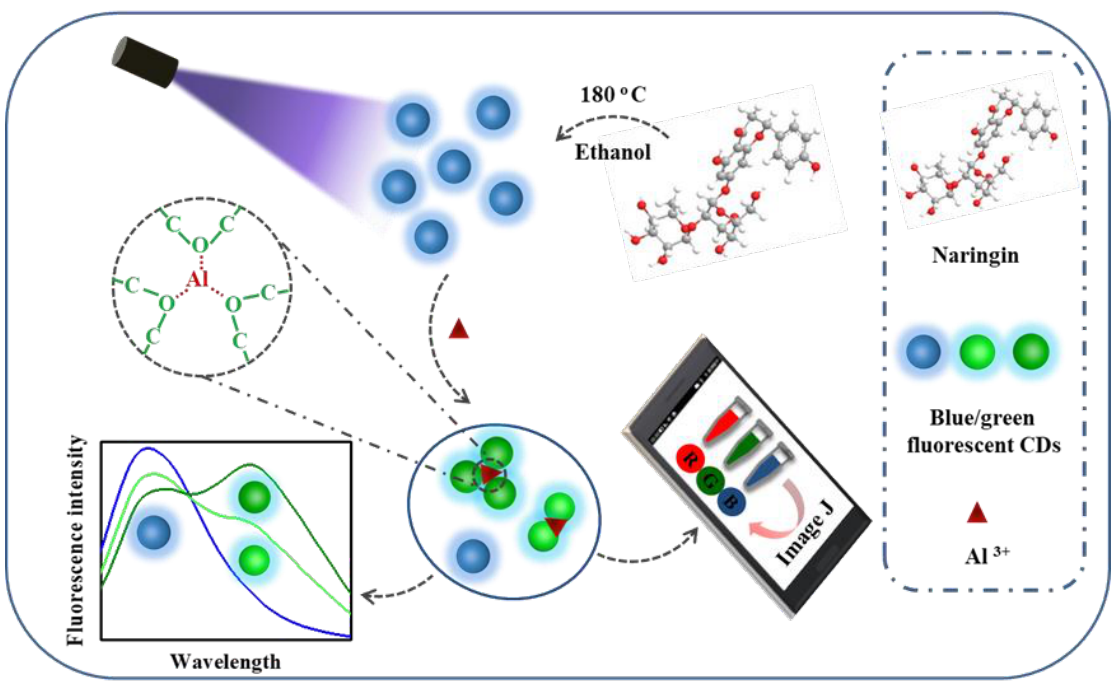
Figure 1. Schematic illustration of the strategy for the detection of Al 3+ .